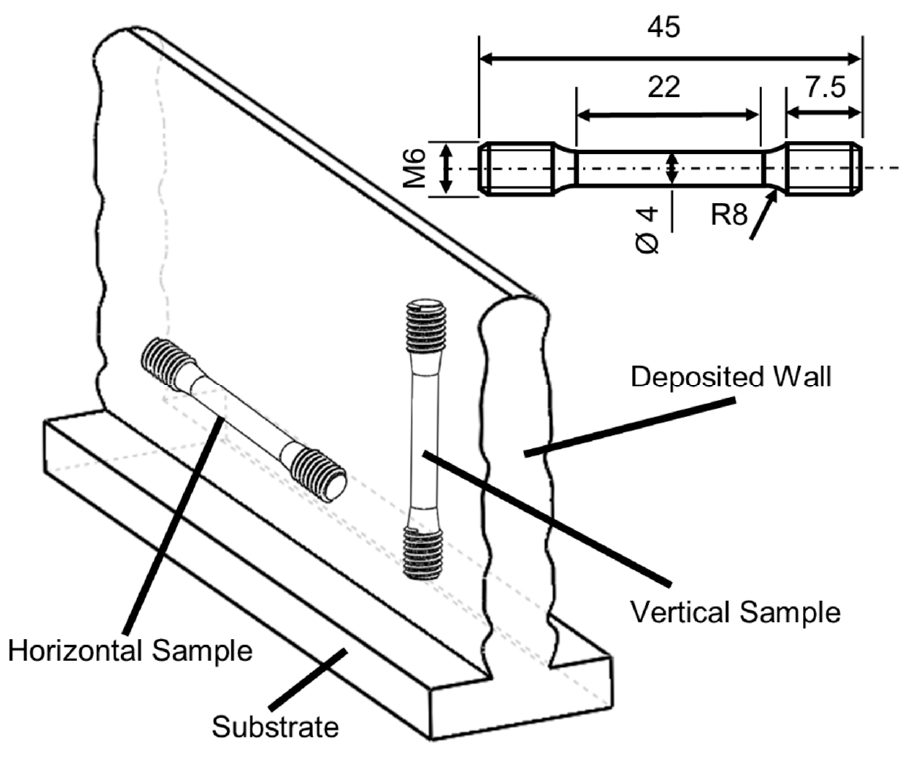
Figure 3. Layout and distribution of specimens with engineering drawing for tensile test.